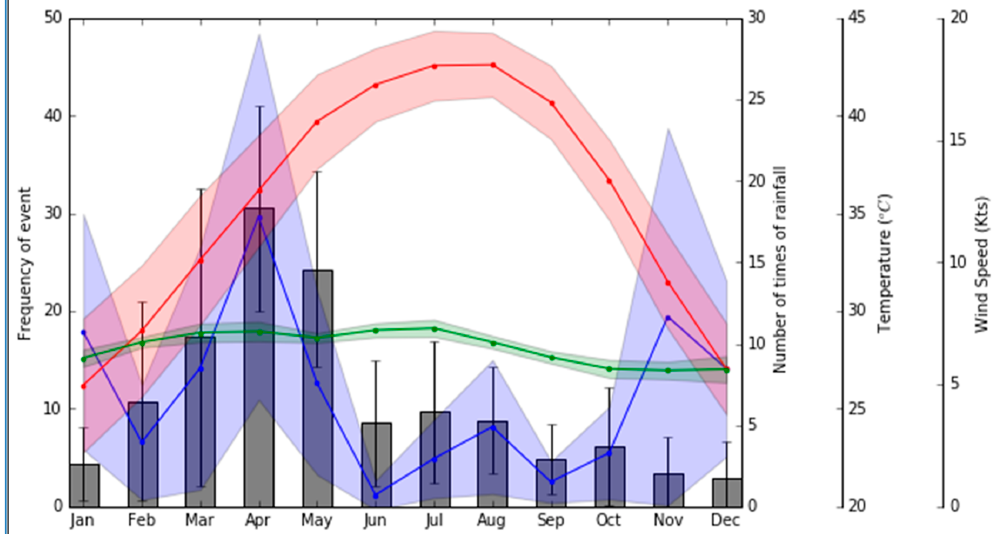
Figure 8. Seasonal variation in (i) the frequency of dust storms in gray, (ii) temperature in red, (iii) frequency of precipitation in blue, and (iv) wind speed in green for all PME stations. The values in the graph represent the average and the associated standard deviation (by error bars or shaded surface) for the period 2000–2016.